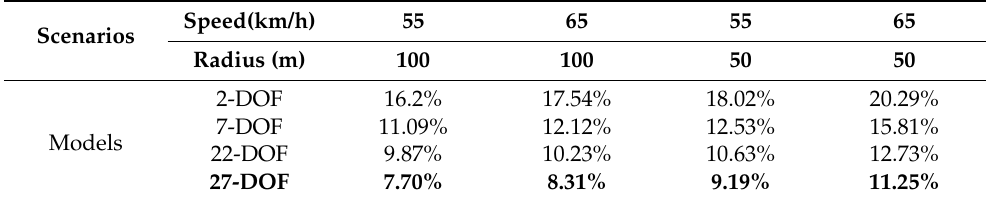
Table 3. Yaw velocity relative error in different scenarios of const radius.